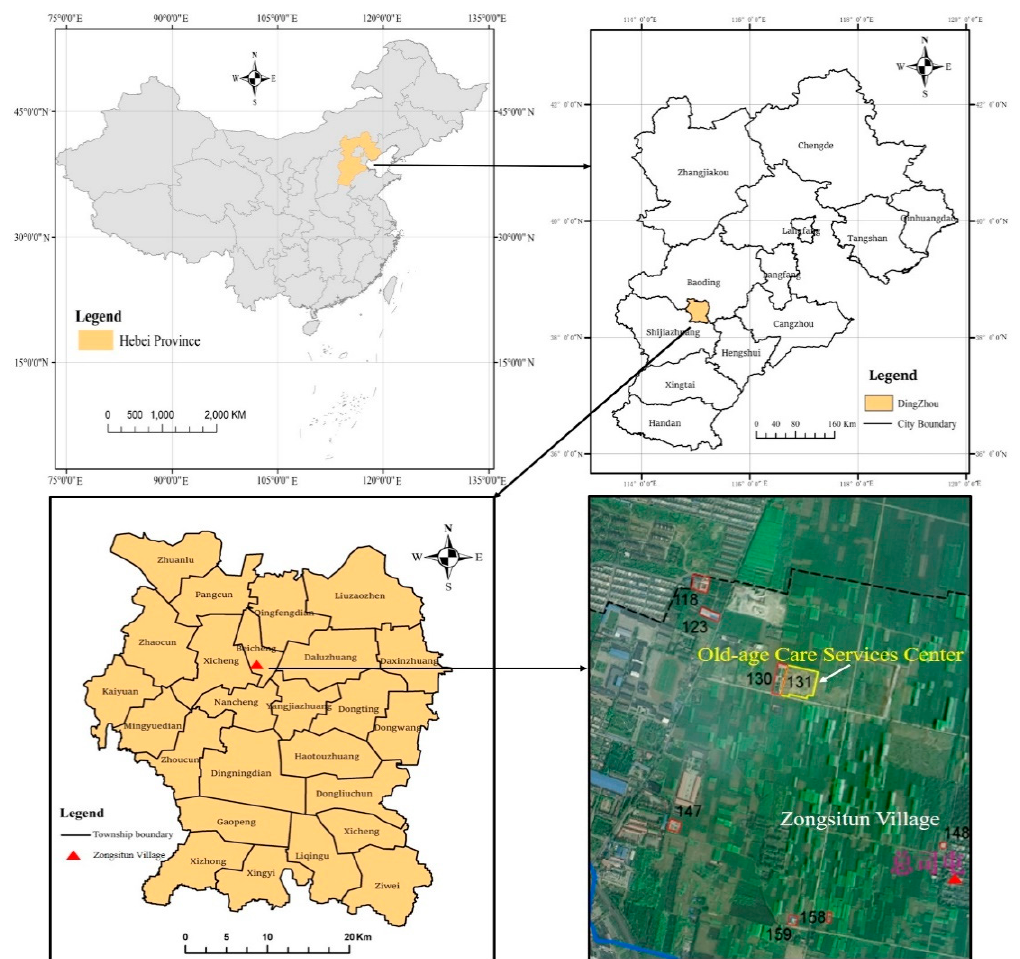
Figure 1. Location of the Jingsong Old-age Care Services Center.